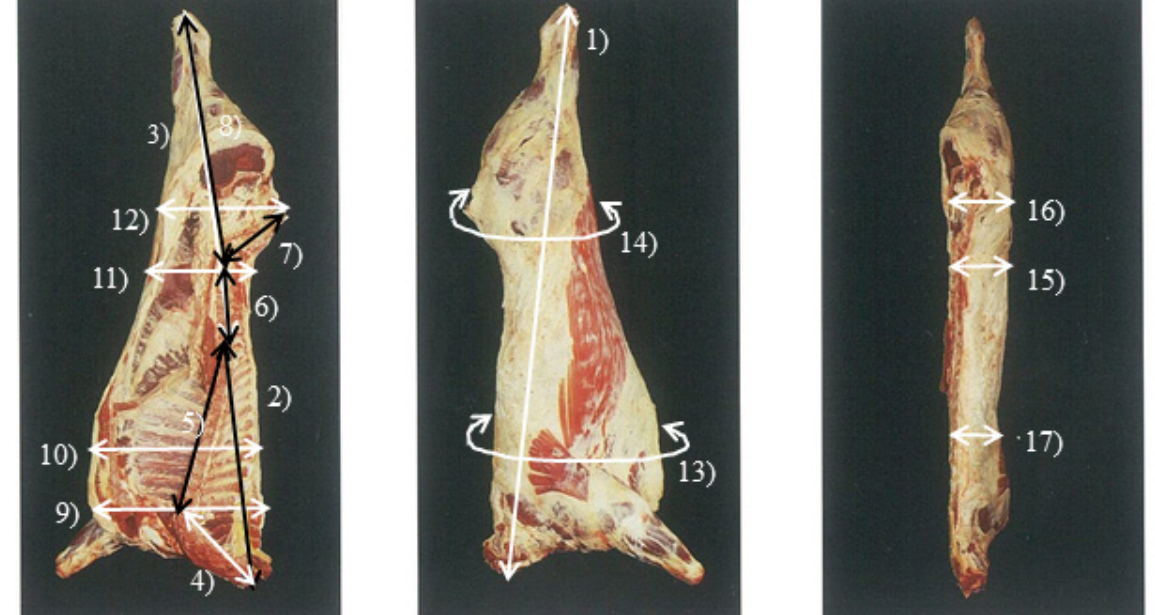
Figure 1. Measurement of carcass size. 1) Carcass length, 2) forequarter length, 3) hindquarter length, 4) cervical vertebrae length, 5) thoracic vertebrae length, 6) lumbar vertebrae length, 7) sacral vertebrae length, 8) 6th lumbar vertebrae to heel length, 9) 7th cervical vertebrae carcass breadth, 10) 5th to 6th thoracic vertebrae breadth, 11) 4th to 5th lumbar vertebrae breadth, 12) 5th sacral vertebrae breadth, 13) 7th to 8th thoracic vertebrae girth, 14) coxae girth, 15) 4th to 5th lumbar vertebrae thick, 16) coxae thick, 17) 7th to 8th thoracic vertebrae